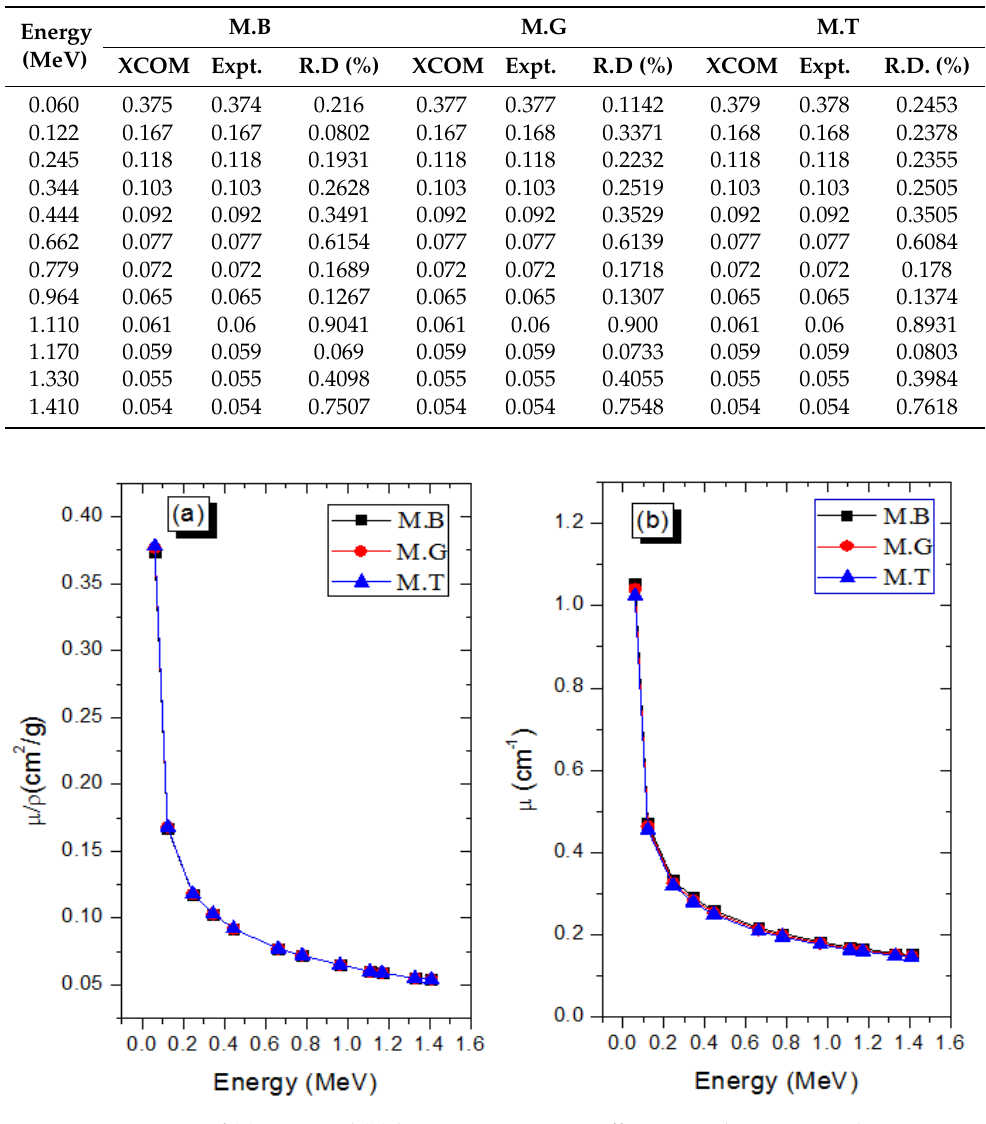
Figure 3. Variations of ( a ) mass and ( b ) linear attenuation coefficients with respect to photon energy of the marble samples.